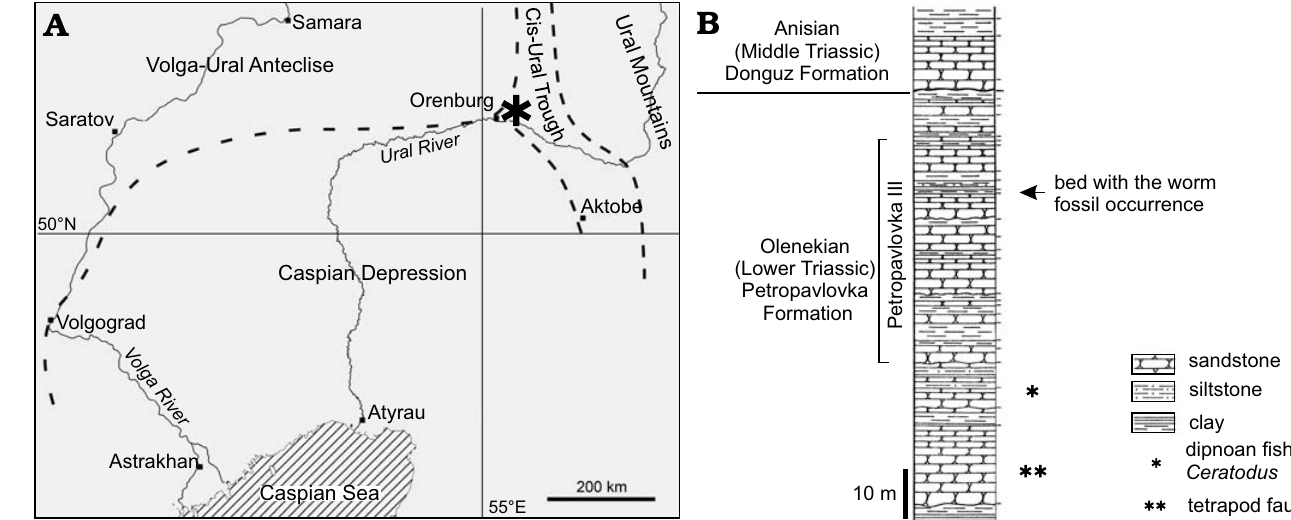
Fig. 1. A . Map showing the Lower Triassic locality Petropavlovka III (asterisk) on the Sakmara River valley bank near the village of Petropavlovka ca. 45 km north-east of the town of Orenburg, Russia, in the tectonic context (dashed lines, boundaries of tectonic regions; modified from Minikh and Minikh 1997). B . Combined stratigraphic log of Petropavlovka II–IV sections (modified from Tverdokhlebov